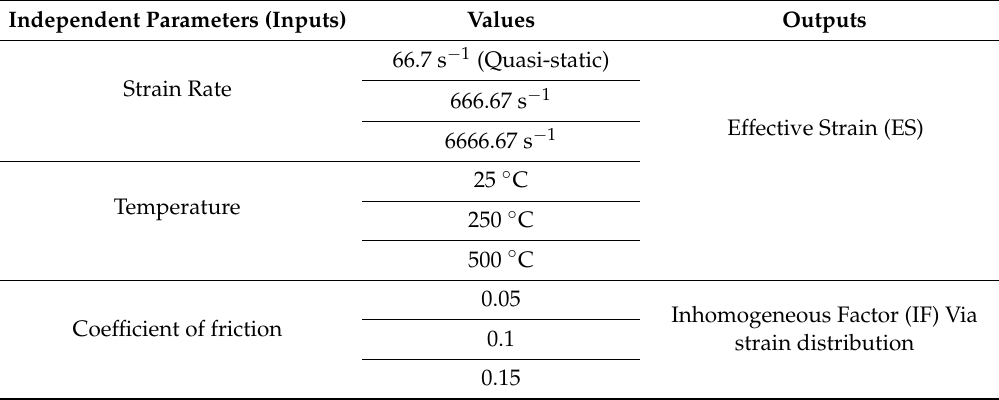
Table 5. Input and output parameters considered in this